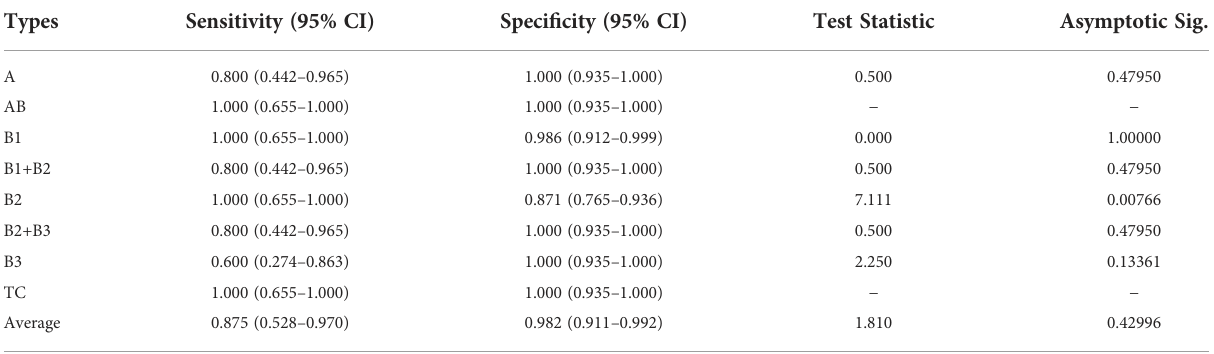
TABLE 5 Quantitative comparisons (sensitivity and speci fi city with 95% CI, test statistic, and asymptotic Sig.) for thymoma typing on the THW dataset.